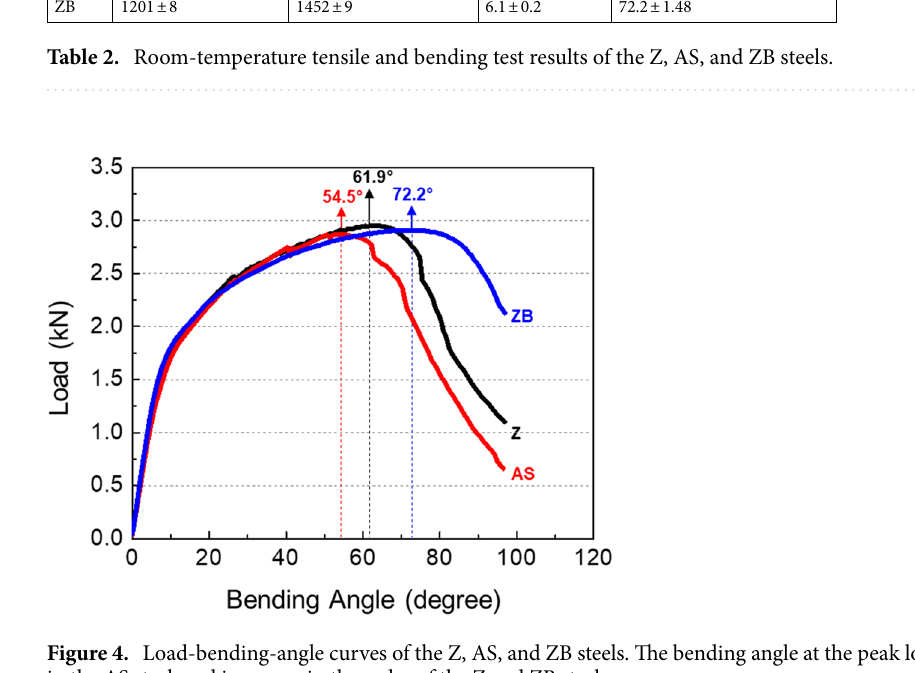
Figure 4. Load-bending-angle curves of the Z, AS, and ZB steels. The bending angle at the peak load is lowest in the AS steel, and increases in the order of the Z and ZB